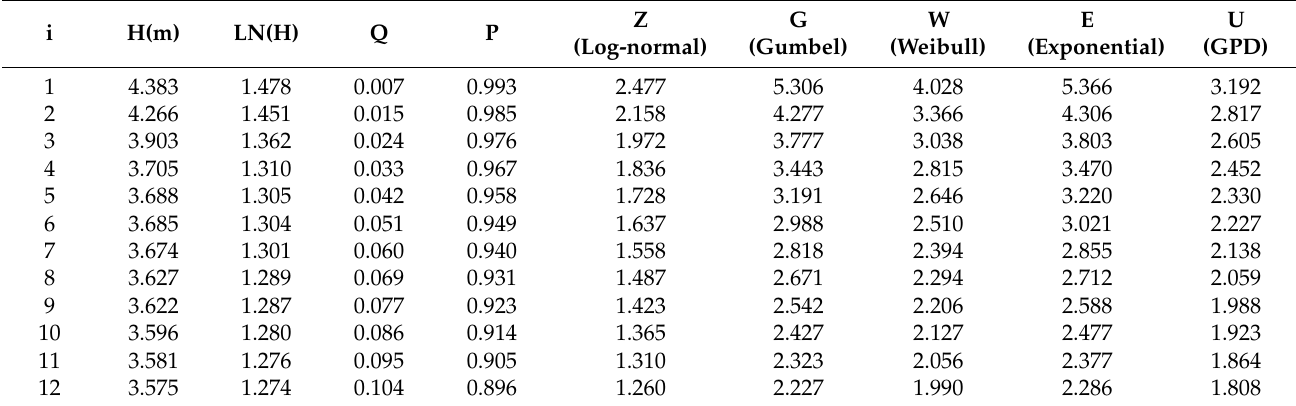
Table 2. Sample calculations using four different distributions.